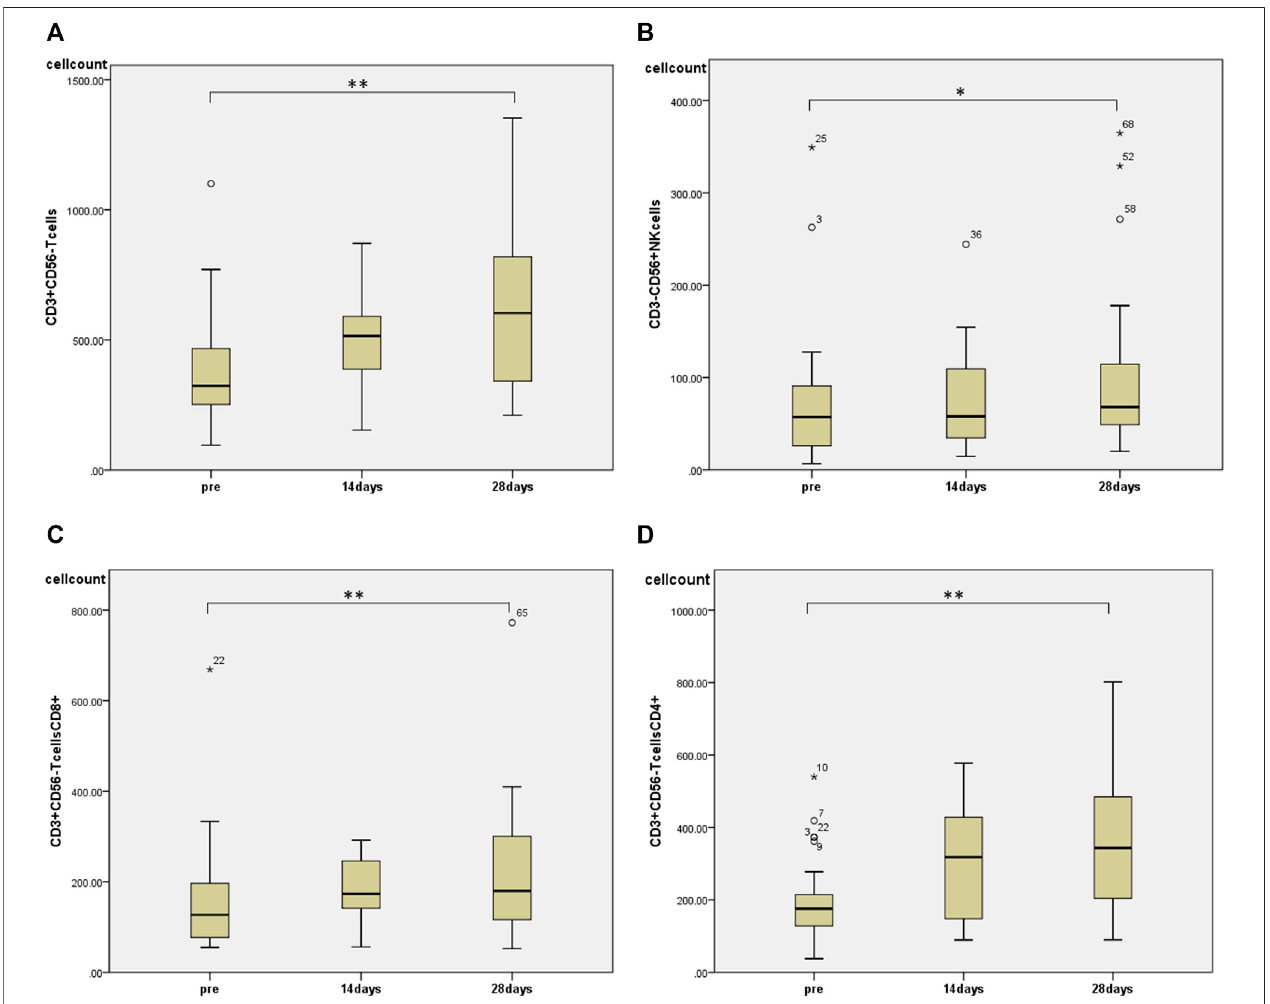
FIGURE 2 | The effects of HET and KKT on circulating peripheral blood mononuclear cells (PBMCs). The administration of HET and KKT resulted in a signi fi cant increase in the (A) T cell population; (B) NK cells; (C) CD 8+ T cells, and (D) CD 4+ T cells. * p < 0.05, ** p < 0.01.